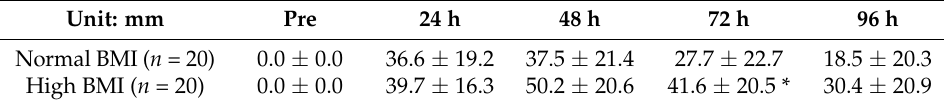
Table 3. Changes in muscle soreness according to the body mass index after eccentric exercise. Unit: mm Pre 24 h 48 h 72 h 96 h Normal BMI ( n = 20) 0.0 ± 0.0 0.0 ± 0.0